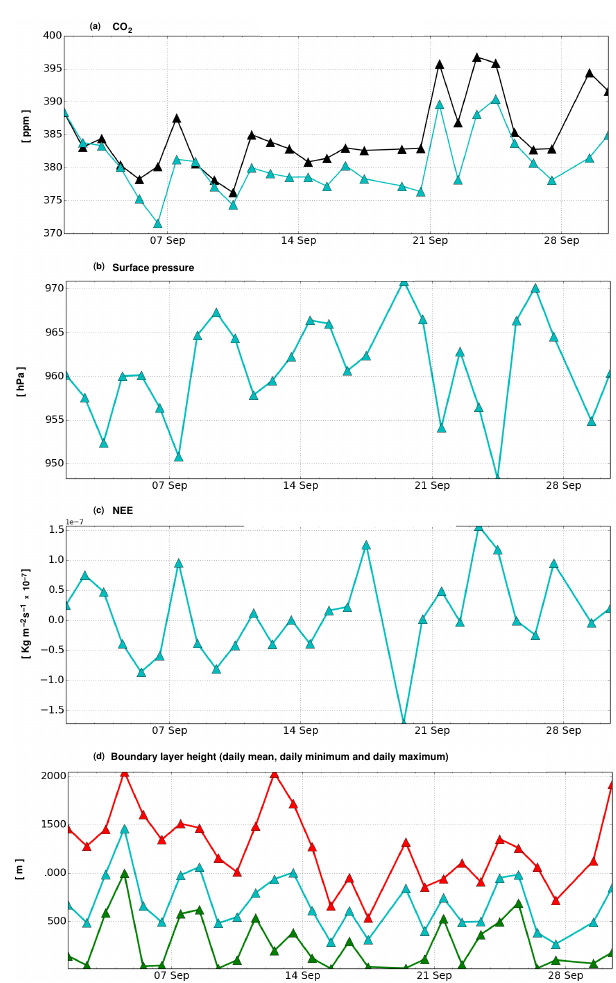
Figure 7. (a) Daily mean dry molar fraction [ppm] of CO 2 from measurements (dark circles) and model (cyan triangles) at 396m above the surface; (b) daily mean surface pressure [hPa]; (c) daily mean modelled NEE [kgm − 2 s − 1 × 10 − 7 ] with negative/positive values representing uptake/release of CO 2 from/into the atmosphere by vegetation; and (d) daily mean, minimum and maximum bound- ary layer height [m] (cyan, blue, red) at the Park Falls NOAA/ESRL tall tower in September